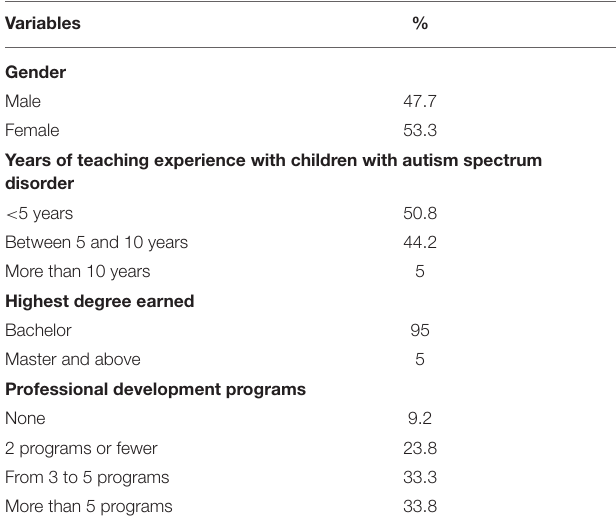
TABLE 1 | Participants’